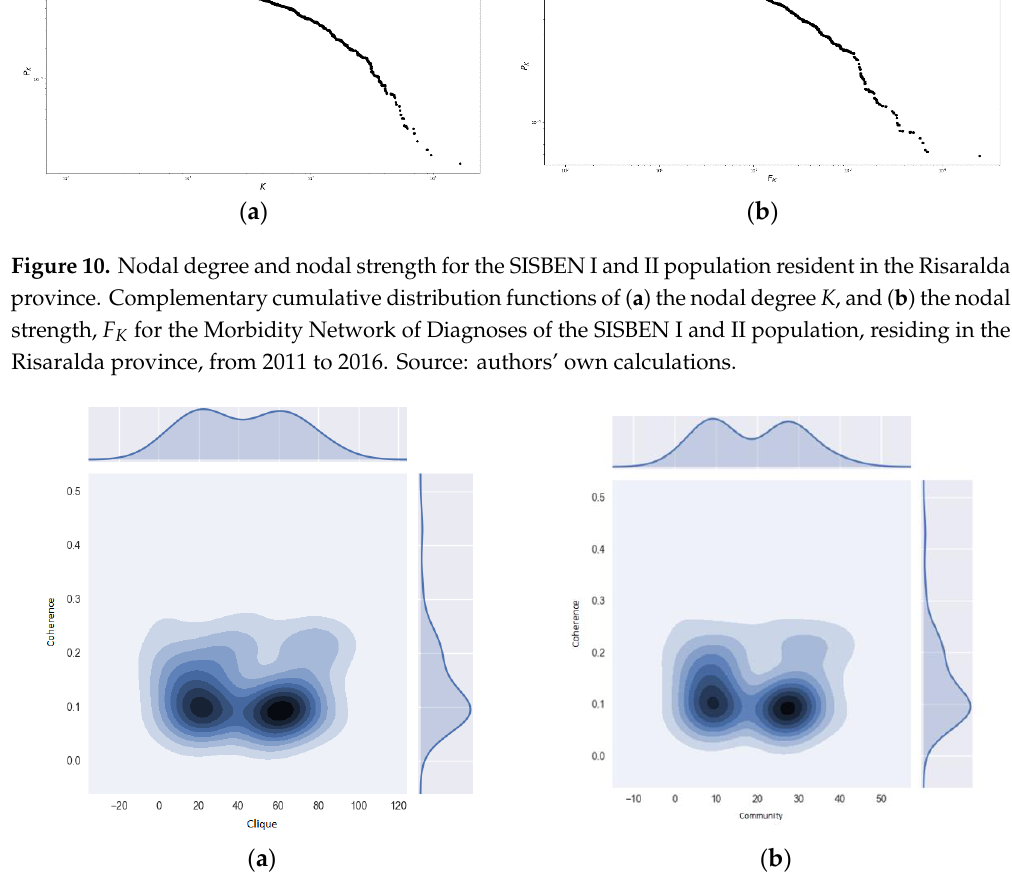
Figure 11. Motif coherence for cliques and SISBEN I and II. Motif coherence for ( a ) cliques and ( b ) SISBEN I and II for the Morbidity Network of Diseases for victims of the armed conflict in Colombia, residing in the Risaralda province, from 2011 to 2016. Source: authors’ own calculations.